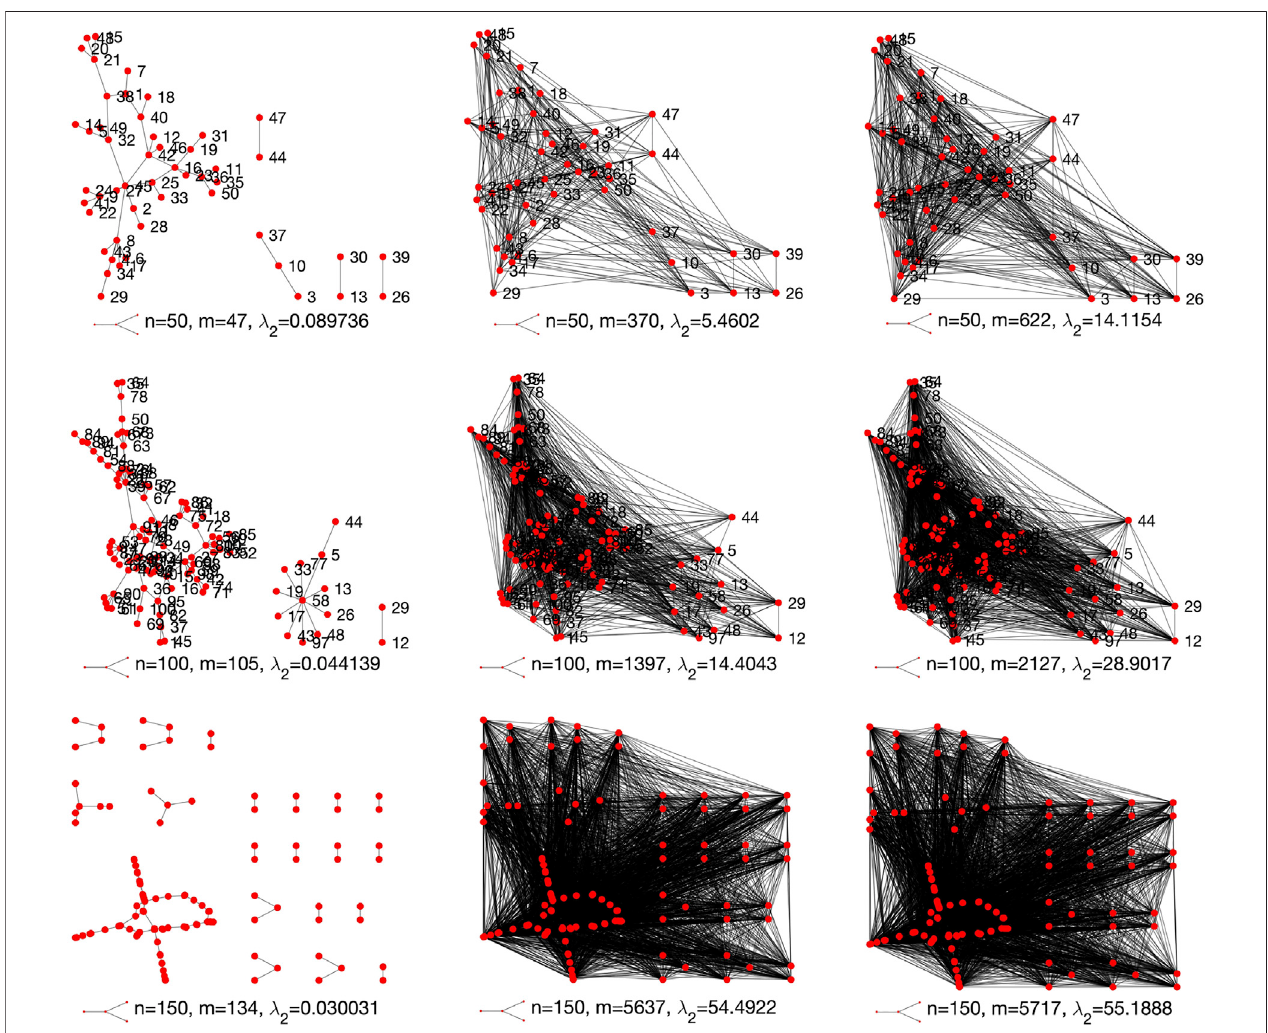
FIGURE 12 | Original ( fi rst column) and optimized structures (second and third columns) the scale-free networks for λ (cid:2) 2.